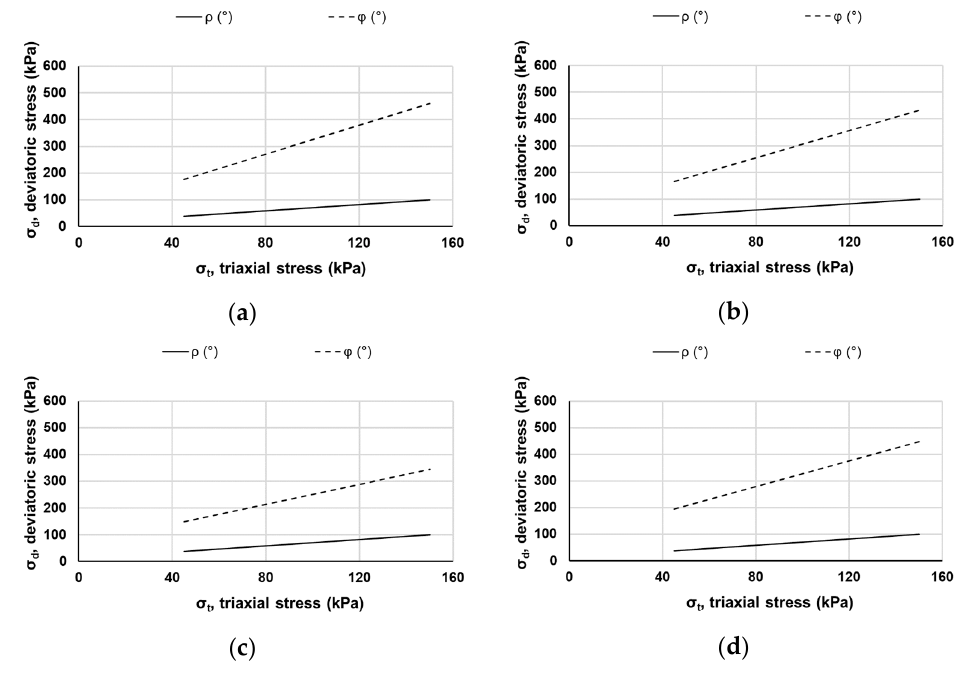
Figure 8. Degree of mobilized shear strength ρ ( ◦ ) and maximum shear strength ϕ ( ◦ ) of ( a ) 0% RPM–100% REM; ( b ) 25% RPM–75% REM; ( c ) 50% RPM–50% REM; and ( d ) 100% RPM–0% REM.